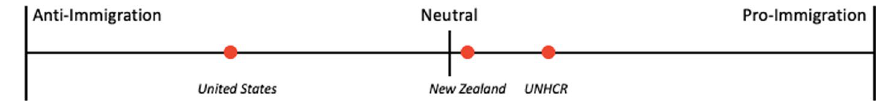
Fig. 1 Intention scale for the use of AI to deliver immigration